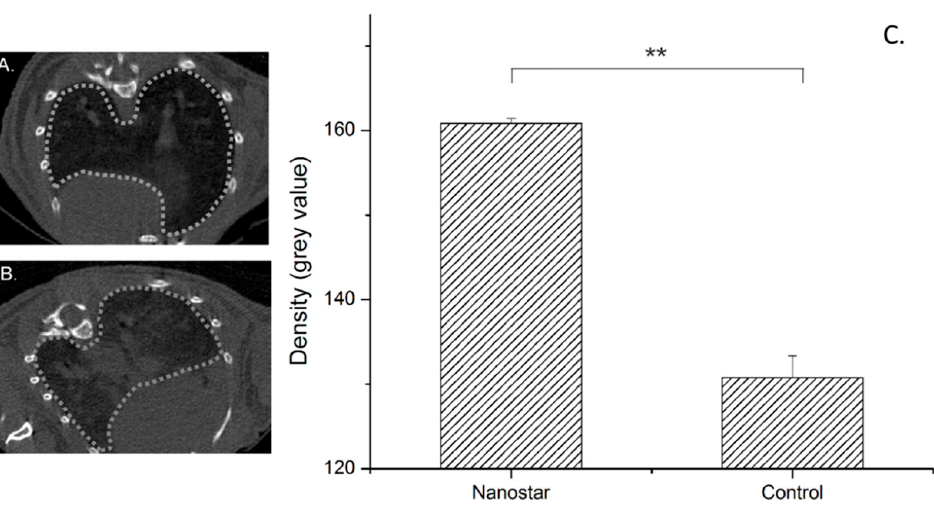
Figure 7. Transverse CT images of mouse lungs after intravenous injection of 500,000 unlabeled ( A ) and SAF-NP-labeled ( B ) SKOV3 cells. ( C ) The dotted grey lines indicate the ROI of the lungs. A positive contrast enhancement was observed after injection of the SAF-NP-labeled cells, as shown in the graph where the density is plotted for both cases. ** p < 0.01.